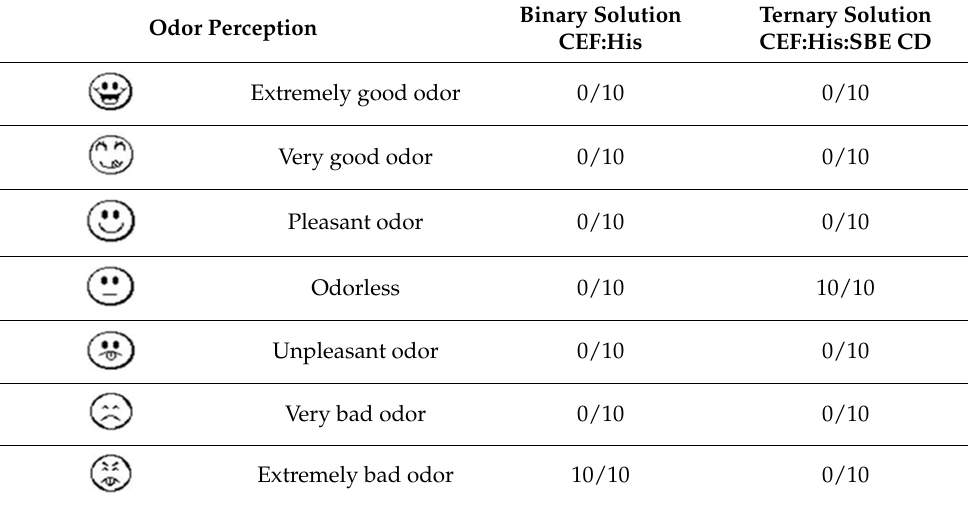
Table 3. ‘Facial Affective Scale’ (FAS) rating for the odor evaluation carried out by 10 healthy volunteers.